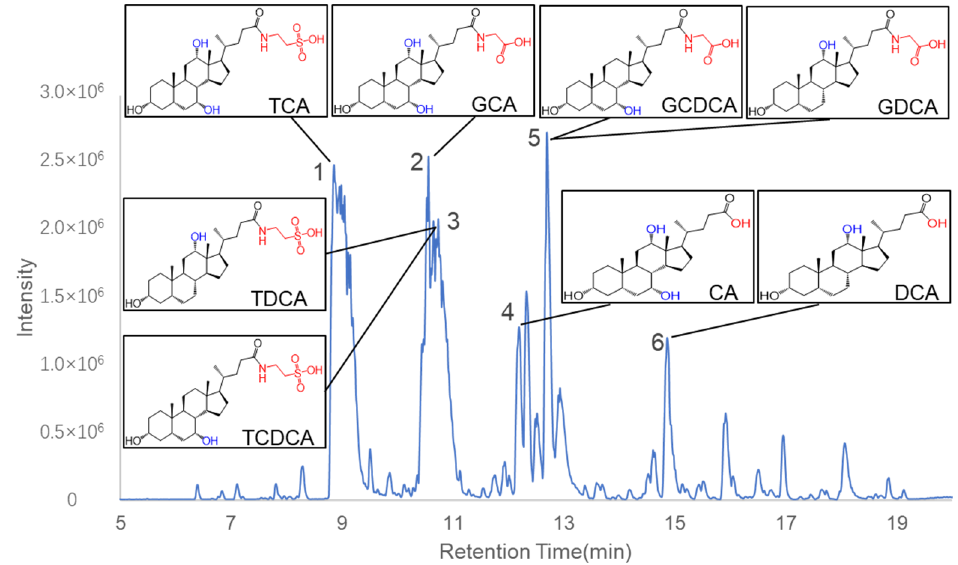
Figure 3. Base peak chromatogram of C. bovis in negative ion mode. Six peaks were identified as bile acids. The chemical structures of the eight major compounds chosen for the following studies were shown in boxes. Table 1. Bile acids identified by UPLC-QTOF-MS in negative ion mode.